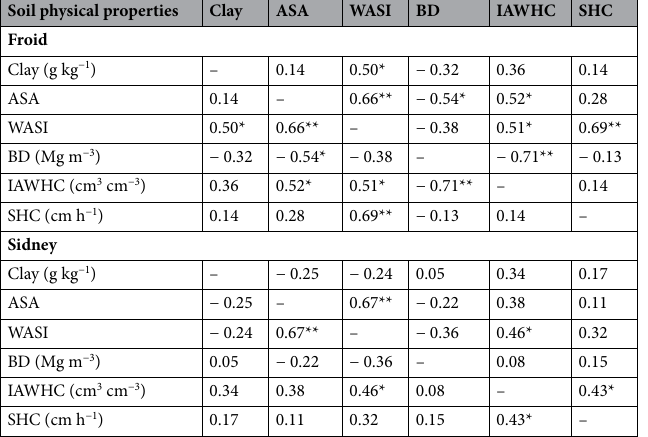
Table 1. Correlation (r) among clay concentration (Clay), average slake aggregate (ASA), wet aggregate stability index (WASI), bulk density (BD), intact core available water holding capacity (IAWHC), and saturated hydraulic conductivity (SHC) at Froid (n = 16) and Sidney (n = 24), Montana. * and ** Significant at P ≤ 0.05 and 0.01,